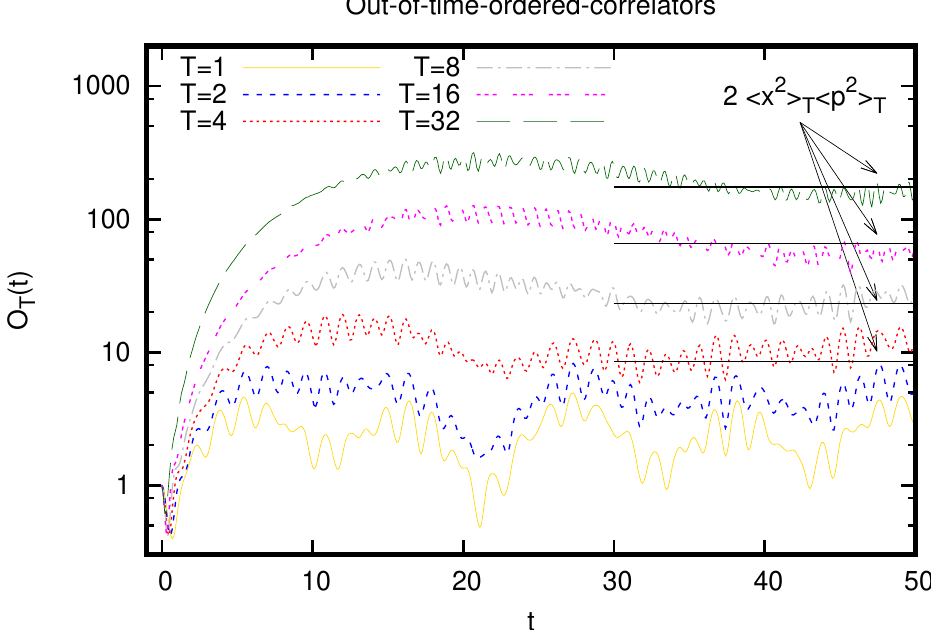
Figure 3 . OTOCs O T ( t ) as a function of time for various temperatures T . For higher temperatures, there is a rapid rise at early times followed by a plateau-like behavior at late times. Note that this rapid rise is not exponential, but rather power-law like. For comparison, the expected behavior of O T ( ∞ ) for a quantum chaotic system (5.5) is shown for T = 4 , 8 , 16 , 32 . a rapid early-time rise followed by a plateau at late times for O rise is clearly not a simple exponential, this qualitative behavior of O